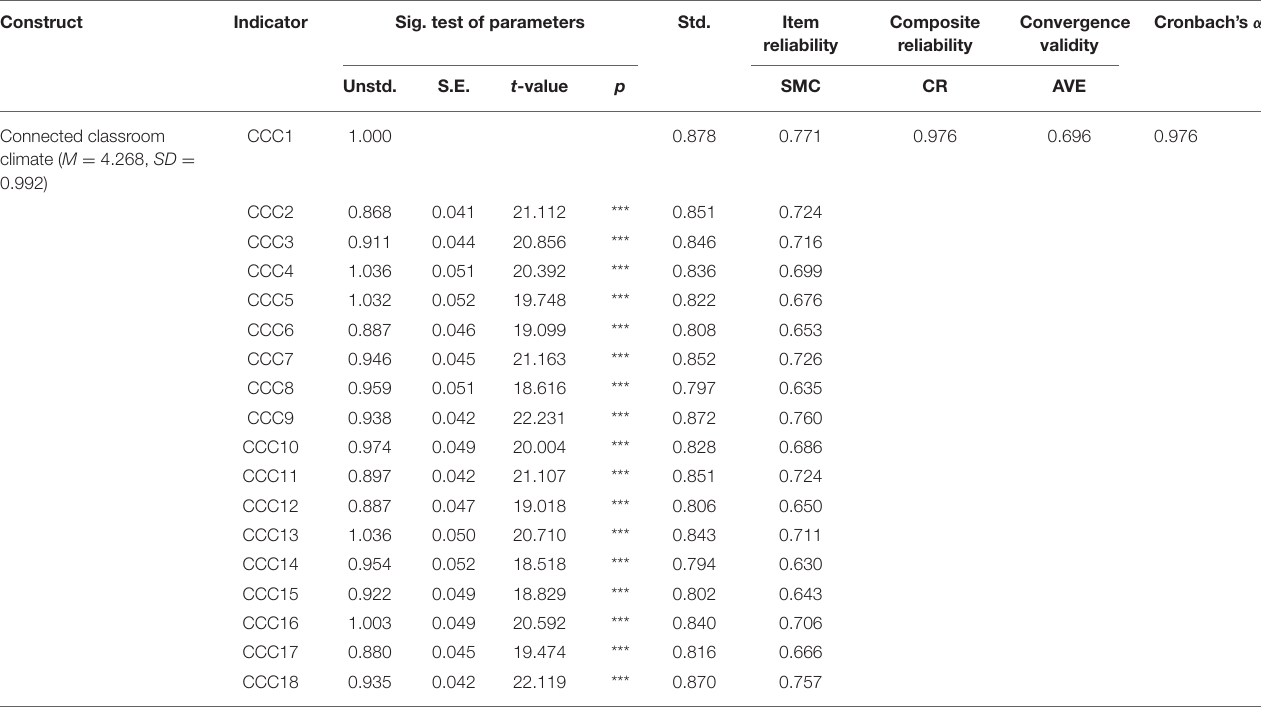
TABLE 4 | Reliability and convergent validity of CCC ( n = 312).